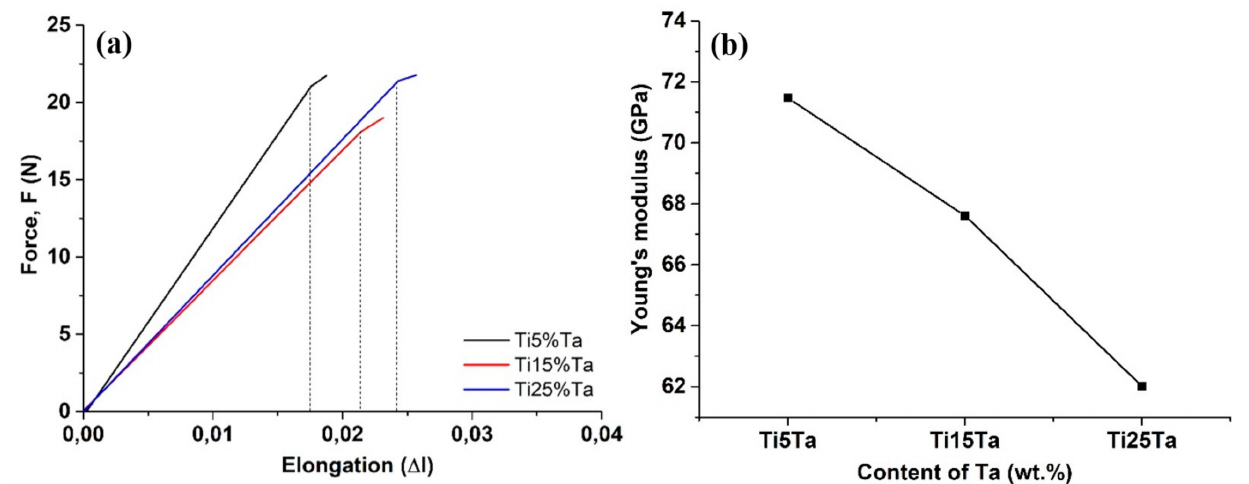
Figure 5. Force–elongation curves of the tested samples ( a ) and variation in elastic modulus with Ta content ( b ).